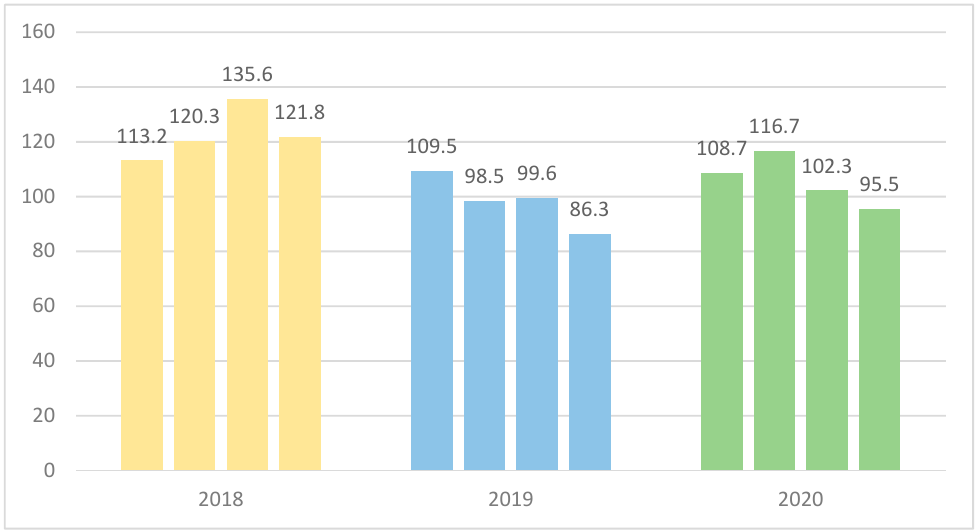
Figure 3. Carbapenems Defined Daily Dose per 1000 Patient Days per quarter and year.